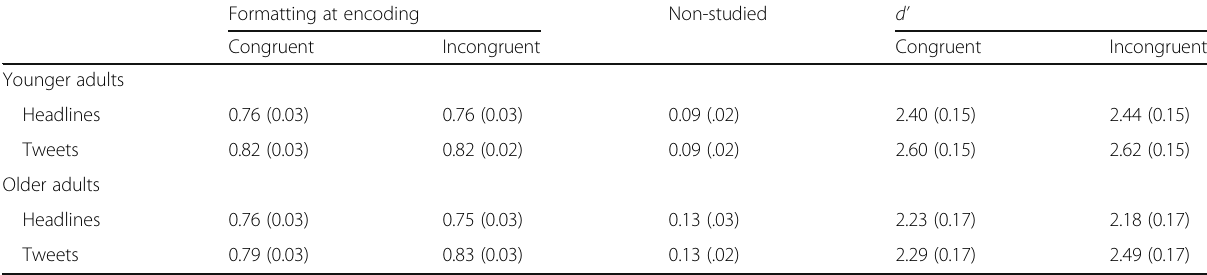
Table 3 Proportion of “ old ” responses and signal detection estimates as a function of age, item content, and item